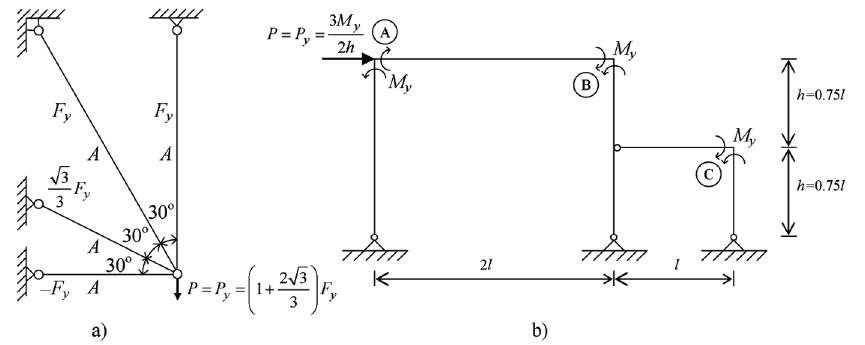
Fig. 1. Two examples of structures constructed of ideal plastic materials: a) truss structure, b) frame